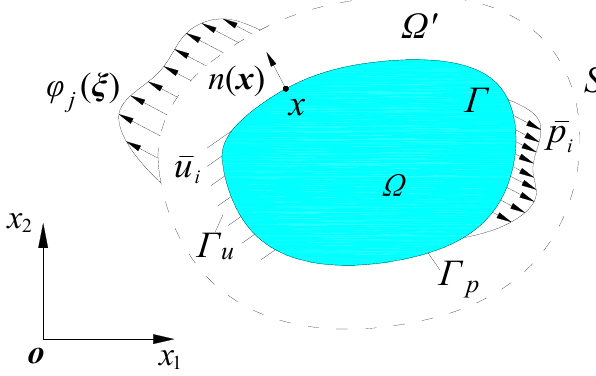
Figure 1. Diagrammatic sketch of the virtual boundary method.